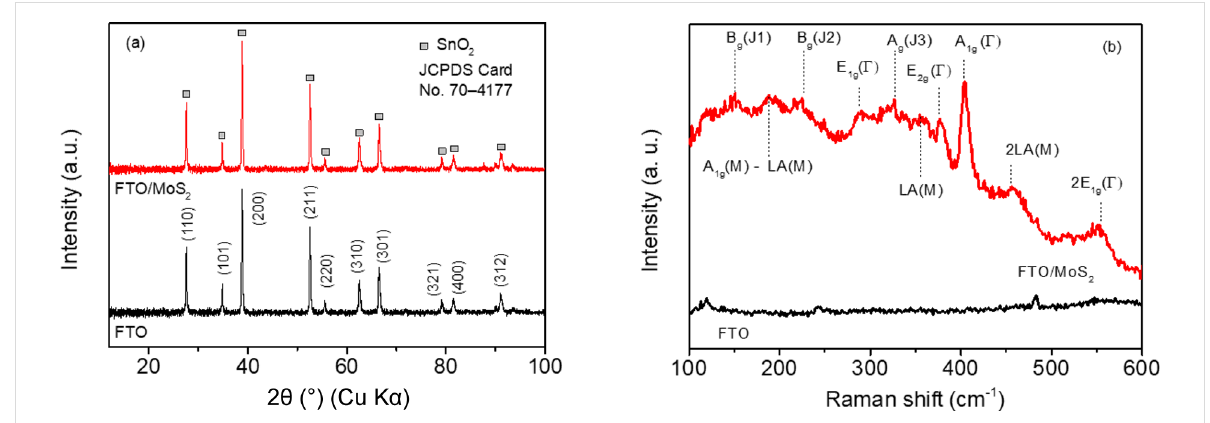
Figure 4: (a) XRD patterns and (b) Raman spectra of the FTO substrate and a thin film of MoS 2 electrodeposited from solution 5.0.